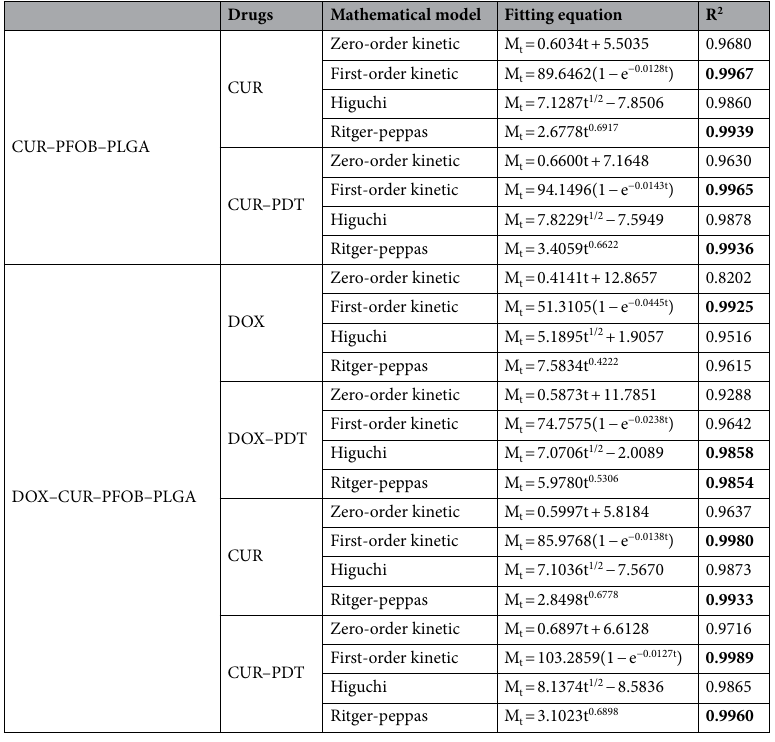
Table 1. Mathematical fitting results of NPs. The fitted equations were all plotted by the Origin 2021 software (https:// www. origi nlab. com/ 2021). Significant values are in